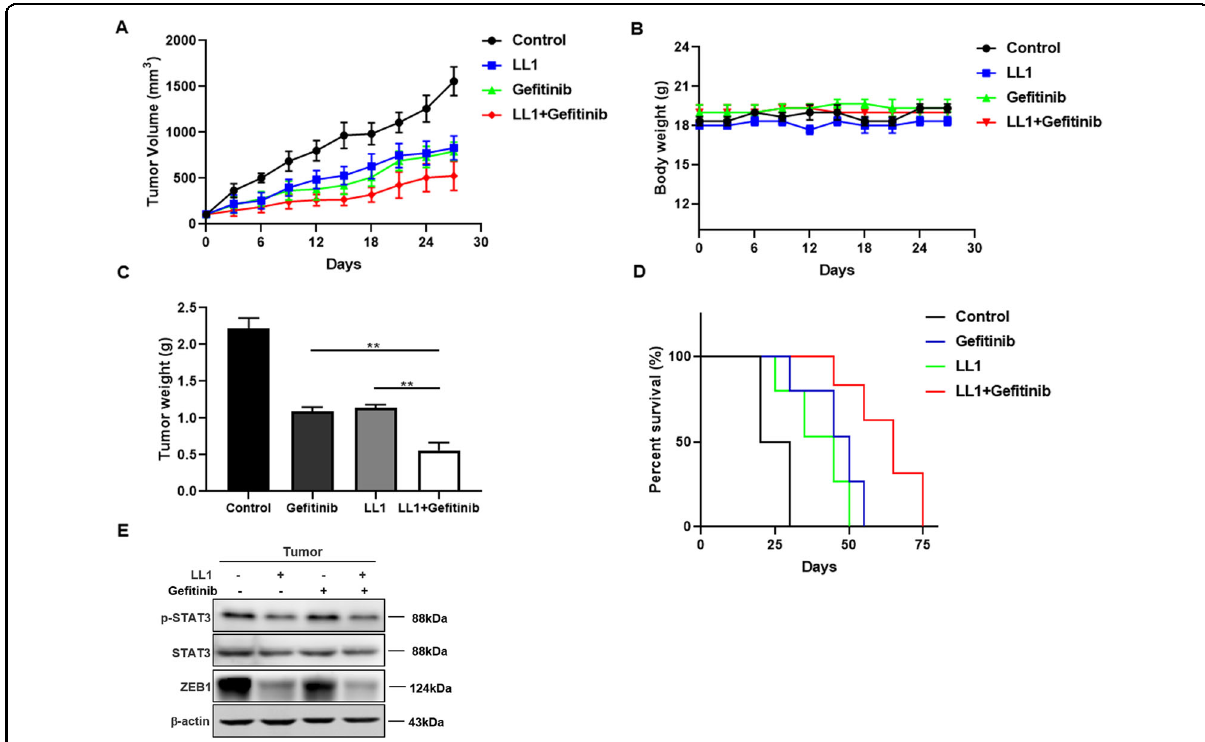
Fig. 6 The combination therapy of ge fi tinib plus LL1 potently inhibits tumor progression in vivo. A The effect of LL1, ge fi tnib, LL1 plus ge fi tnib or vehicle on tumor volume of subcutaneous A549/GR xenografts in nude mice ( n = 6). B , C Body weight and tumor weight from indicated treatment groups. D Survival curves ( n = 6 per group). E The expression of ZEB1, STAT3, and p-STAT3 were examined by Western blot. Data were means ± SD relative to control group. **p <